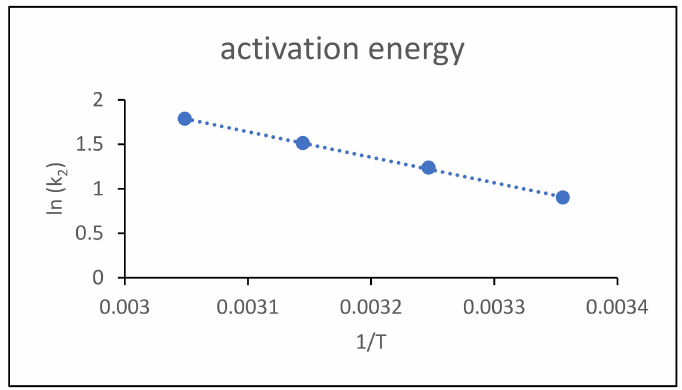
Figure 16. Arrhenius plot for adsorption of CR dye onto UCs.